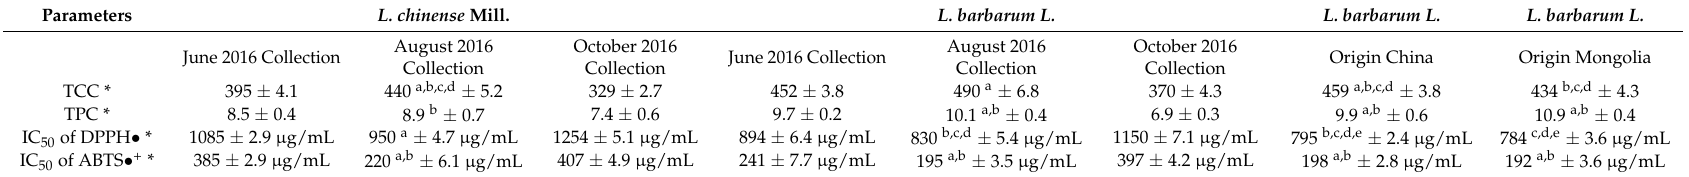
Table 1. Bioactive properties of Lycium barbarum L . and L. chinense Mill. fruits cultivated in central Greece and imported.